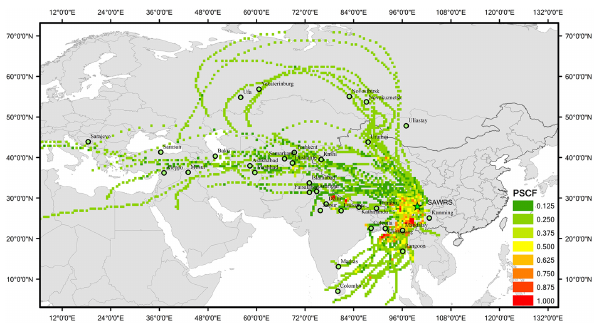
Figure 15. The potential sources and transport pathways of TGM at SAWRS identified by the PSCF. Myanmar, the Bay of Ben- gal, northern India, western Sichuan province and western Yunnan province were likely the potential source regions for